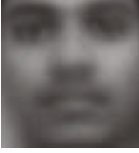
Figure 7: Template.